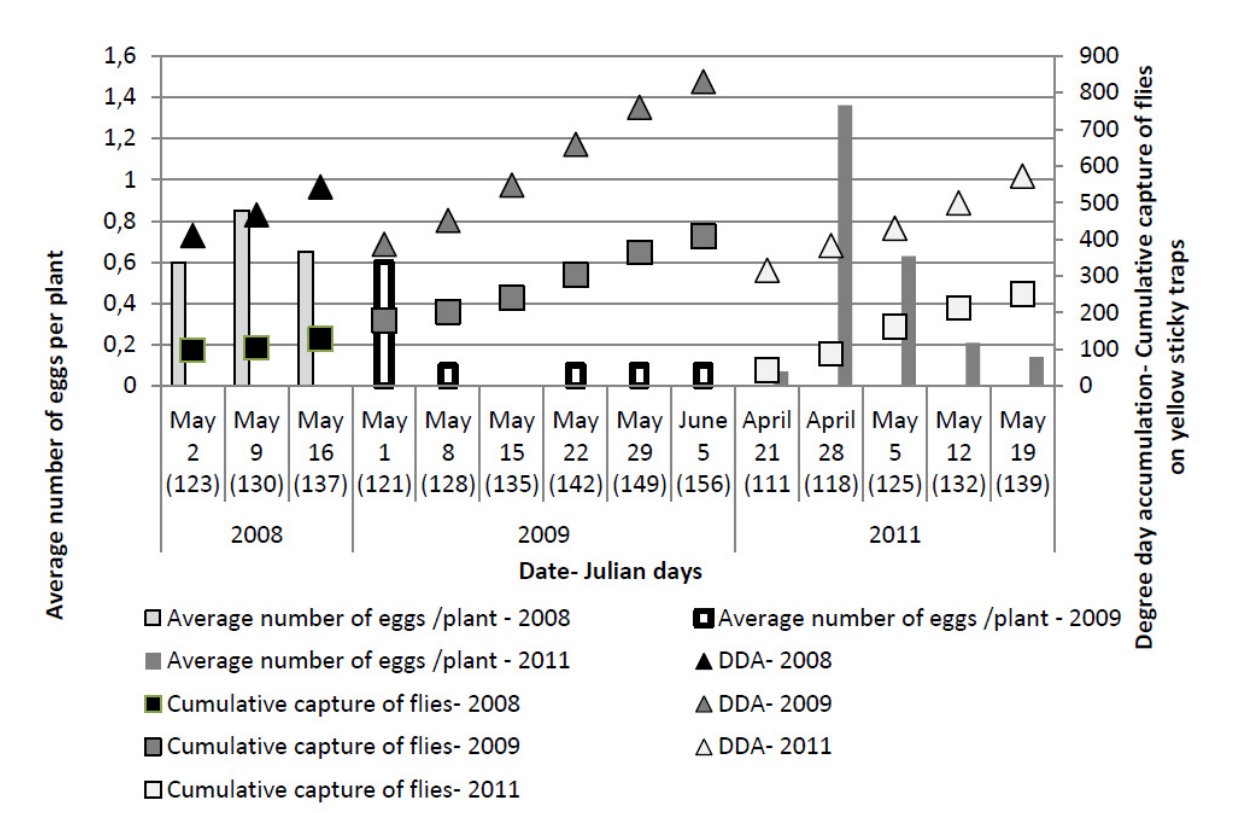
Figure 3. Numbers of Delia radicum (L.) eggs per plant on early cabbage, compared with cumulative numbers of D. radicum adults on yellow sticky traps and DDA over three field seasons (2008, 2009,